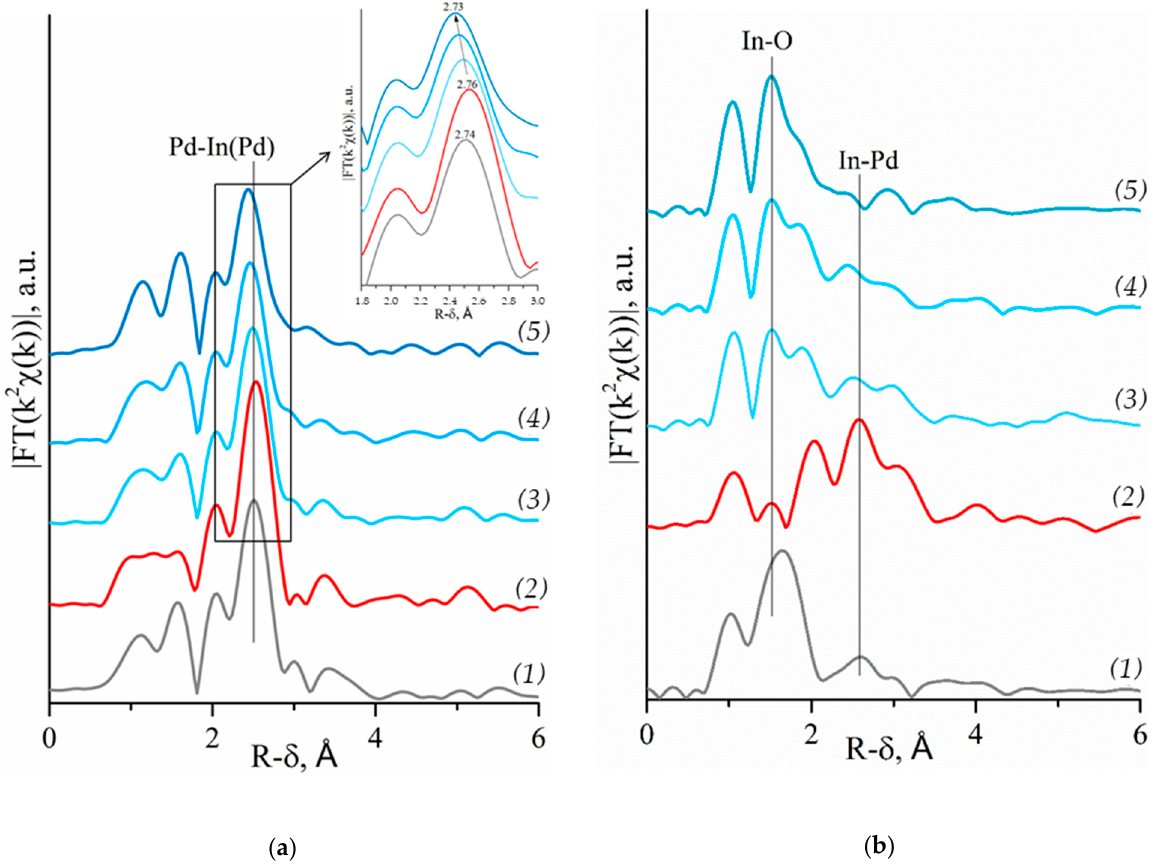
Figure 2. Fourier transforms of Pd ( a ) and In ( b ) K-edge EXAFS spectra measured in situ after specific treatments: (1) initial sample (2) reduction at 500 °C for 1 h (3) oxidation at 25 °C for 30 min (4) oxidation at 100 °C for 30 min (5) oxidation at 250 °C for 30 min. Table 1. Alteration of coordination numbers during the in situ treatments of PdIn/Al 2 O 3 catalyst. X-ray Absorption